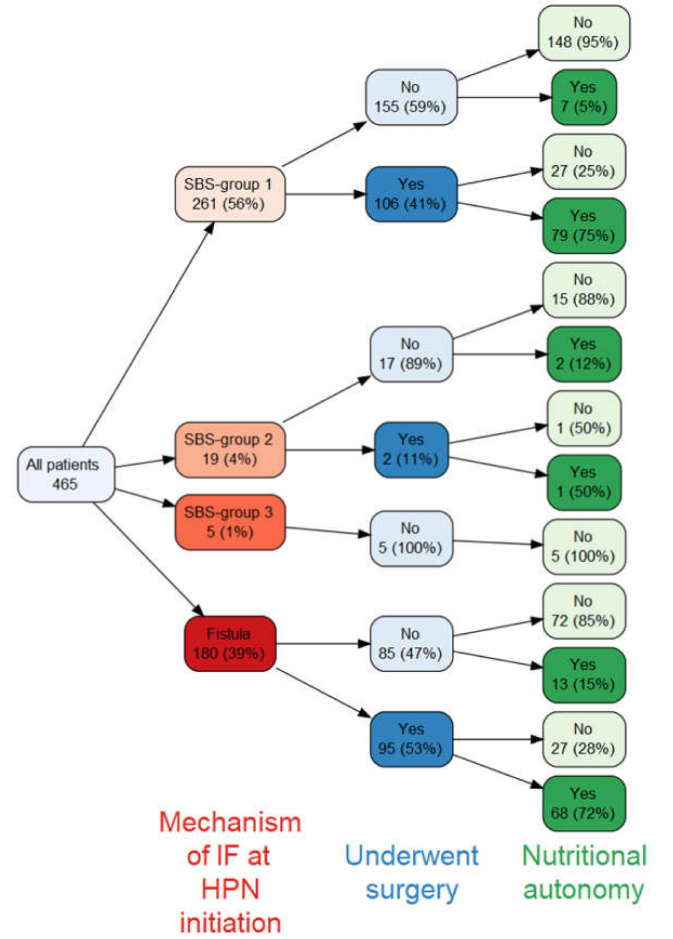
Figure 3. Relationship between mechanism of IF at HPN initiation, subsequent surgery and achieving nutritional autonomy. HPN, Home Parenteral